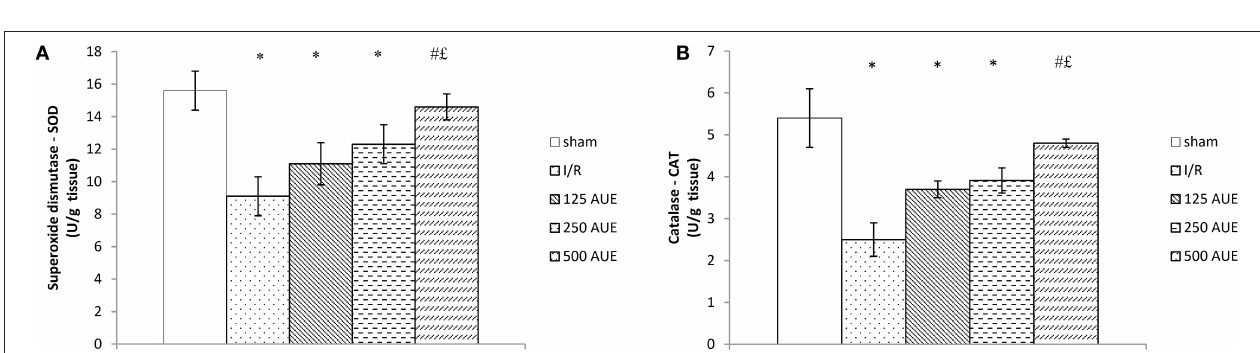
FIGURE 5 | Effects of consumption of increasing doses of AUE on the value of antioxidant defense system in heart tissue measured as superoxide dismutase (SOD) (A) , catalase (CAT) (B) ( n = 50, 10 animals per group). Values are shown as mean ± SE. *Statistically significant difference at the level of p < 0.05 in relation to the sham group; # Statistically significant difference at the level of p < 0.05 compared to I/R group; £ Statistically significant difference at the level of p < 0.05 compared to